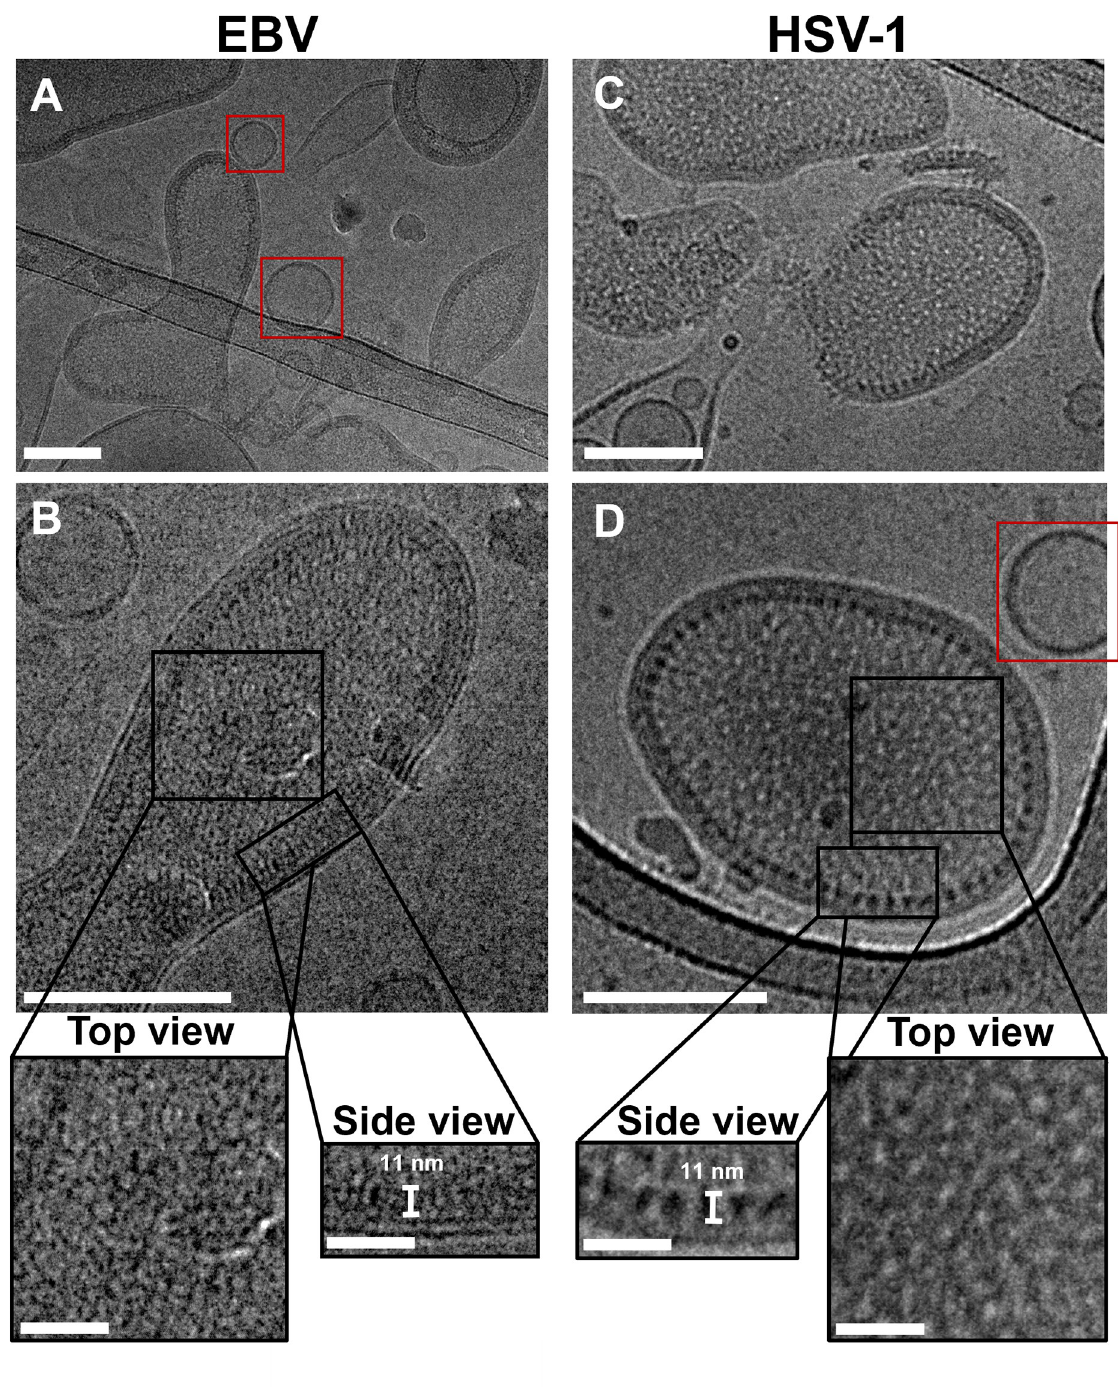
Fig 7. EBV and HSV-1 NEC form internalized membrane-bound coats on liposomes. Cryo-EM shows that both EBV NEC215-N31S BFLF2 (A, B) and HSV-1 NEC220 (C, D) form internal membrane-bound coats. Both NECs are ~11 nm in height, as previously determined for HSV-1 NEC. HSV-1 NEC forms the canonical coats (B inset; top views) also seen by our group in previous publications [25,43] while the oligomeric arrangement of the EBV NEC coats is yet unclear. Red boxes denote LUVs not bound or budded by either NEC with thinner membranes. Scale bars = 100 nm. Inset scale bars = 25 nm. Insets are shown on the same scale.